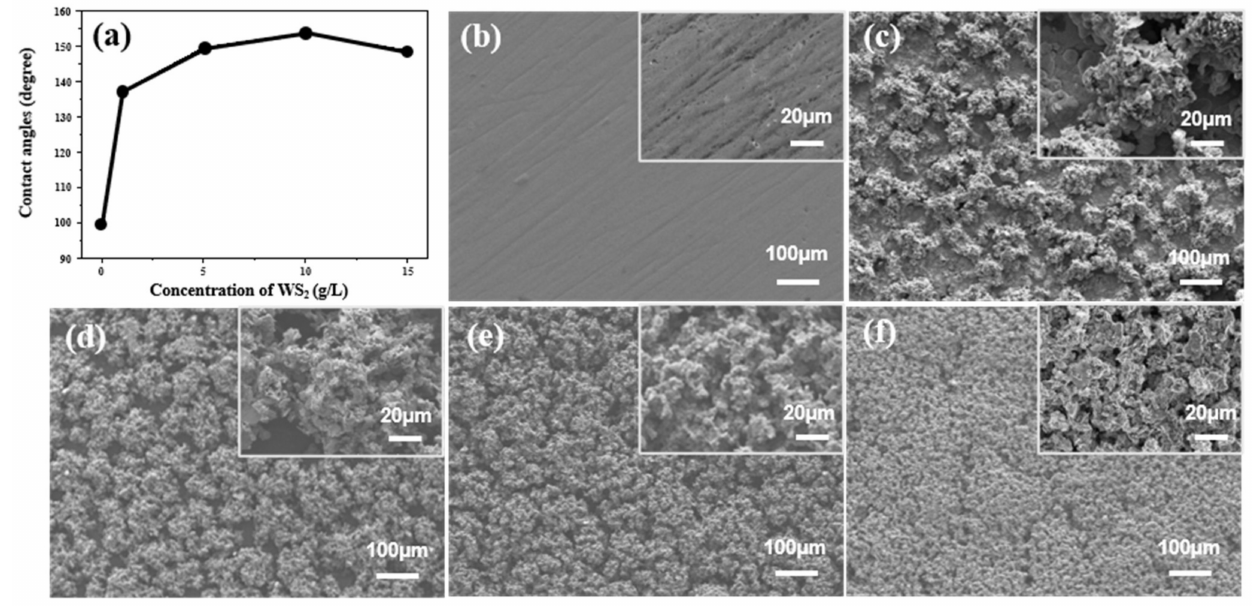
Figure 11. The WCA change trend ( a ) and SEM images ( b – f ) of the Ni-Co/WS 2 nanocomposite coatings prepared with different concentrations of WS 2 .